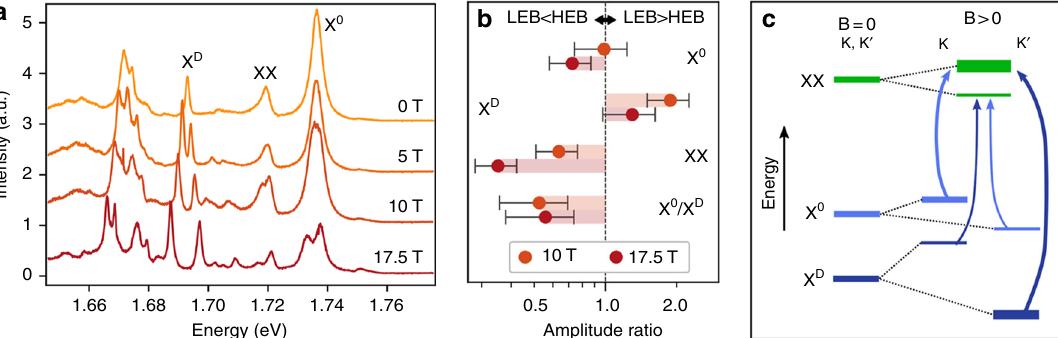
Fig. 2 Zeeman splitting and non-equilibrium distribution of biexciton emission. a A strong out-of-plane magnetic fi eld splits most emission peaks into pairs. The splitting of XX is similar to that of the X 0 feature ( g -factor 4.4 ± 0.5), whereas the splitting of the X D feature is larger because of its non-zero spin. b The ratios of amplitudes of the fi tted low-energy branch (LEB) and high-energy branch (HEB) of the emission spectra. Unlike the X D pair, the XX emission pair exhibits inverted populations between the HEB and LEB. The LEB/HEB ratio of the XX pair is similar to that of X 0 /X D . The error bars for X 0 , X D , and XX are conservative estimates. c A diagram of the biexciton intervalley con fi guration as probed through the PL measurements in a magnetic fi eld. The B- fi eld splits the bright (light blue) and dark (dark blue) exciton into pairs according to their valley index ( K , K ′ ). Analysis of the PL intensities shows that the biexciton is composed of excitons from different